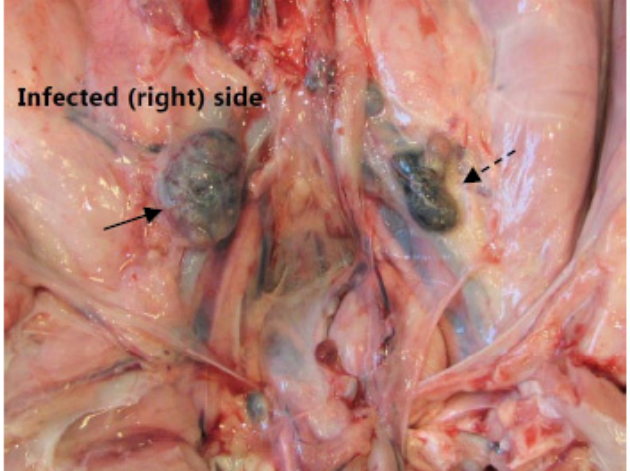
Figure 2. Medial iliac lymph nodes. A photo at necropsy of the caudal pig abdomen. The picture shows the right enlarged medial iliac lymph node (solid arrow) draining the infected hind limb. The lesser left lymph node (dashed arrow) drained the left non-infected left hind limb.